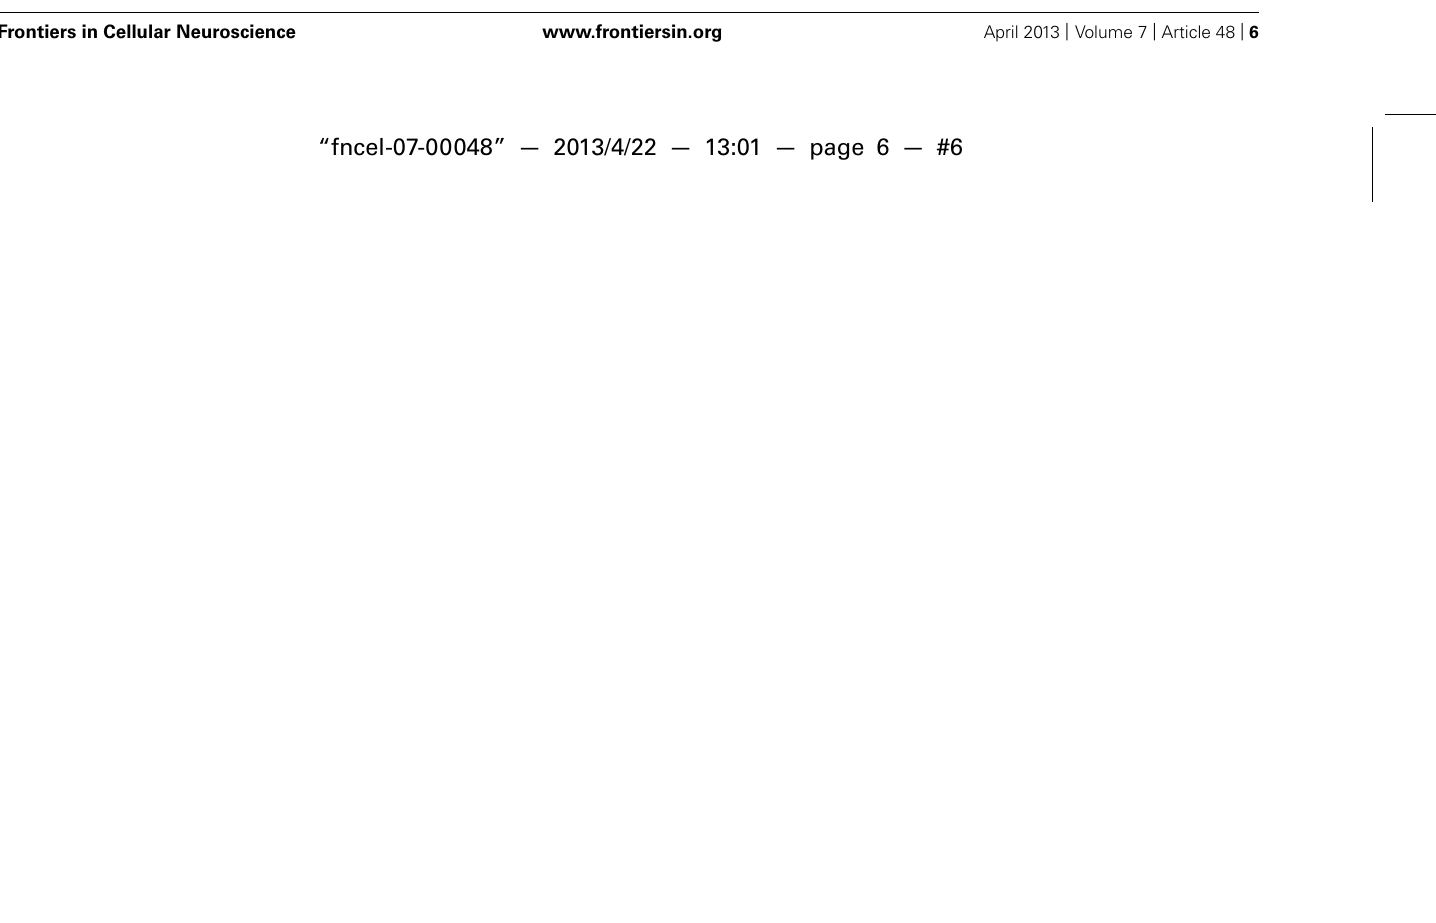
FIGURE 4 |Warm preparation temperature allows patch-clamp recordings from mature and old DCN neurons. Top panel: Representative examples of voltage responses of DCN neurons to step current injections (two leftmost panels) as well as population average AP shapes in juvenile (less than P30) and mature (1–7 months old) animals are nearly indistinguishable. Bottom panel: Comparison of current-versus-firing (with linear polynomial fits and 95% prediction bounds), spike frequency accommodation (vertical bars denote frequency standard error values. All values are normalized to the first inter-spike interval firing frequency; a dashed line demarcates the starting value) and intrinsic membrane measures ( R m (M (cid:2) ), membrane time constant (Tau, ms), AP amplitude (AP amp, mV), AP threshold (APTH, mV), AHP depth (AHP, mV), and I h -sag (mV)) reveal no statistically significant differences between juvenile and old DCN neurons (Values: R m : young: 101.5 ± 11.8 M (cid:2) , old: 130.9 ± 17.9 M (cid:2) ;Tau, young: 13.6 ± 4.7 ms, old: 20.3 ± 2.7 ms; AP amp: young: 61.0 ± 3.4 mV; old: 63.6 ± 2.3mV; APTH: young: − 48.6 ± 2.0 mV; old: